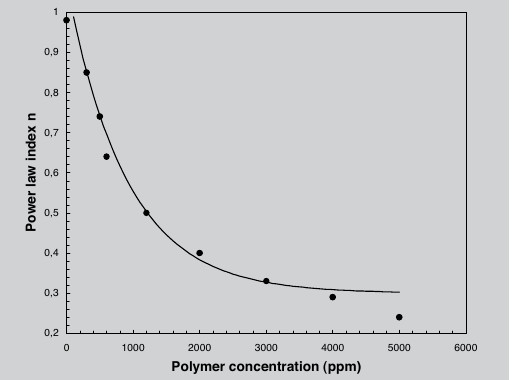
Figure 1 (left above): Apparent viscosity as a function of shear rate at different Xanthan concen- trations. Figure 2 (right above): Power law index versus Xanthan concentration. Figure 3 (left below): Apparent viscosity as a function of shear rate for different Xanthan concen- trations. The straight line represents the power law model (power law parame- ters in Table 1). Table 1: Power law coefficients (consistency k and power law index n) for the three suspending fluids